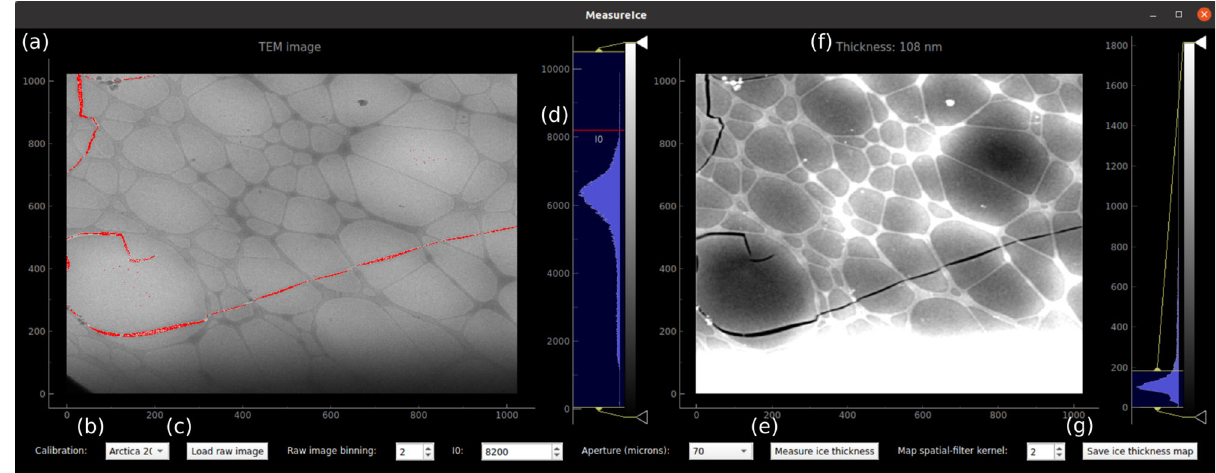
Fig. 6 Screenshot of the MeasureIce software tool. a In the left panel a raw TEM image is displayed, b the calibration fi le is selected via the drop-down menu, and c a new image can be loaded by pressing “ Load raw image ” . d The quantity I 0 , the incident intensity of the electron beam is set using the red line on the histogram or using the input on the bottom of the interface. e An ice thickness map is generated by pressing the “ Measure ice thickness ” button with ( f ) the ice thickness map is displayed in the right panel of the interface which can be saved by pressing ( g ) “ Save ice thickness map ” .